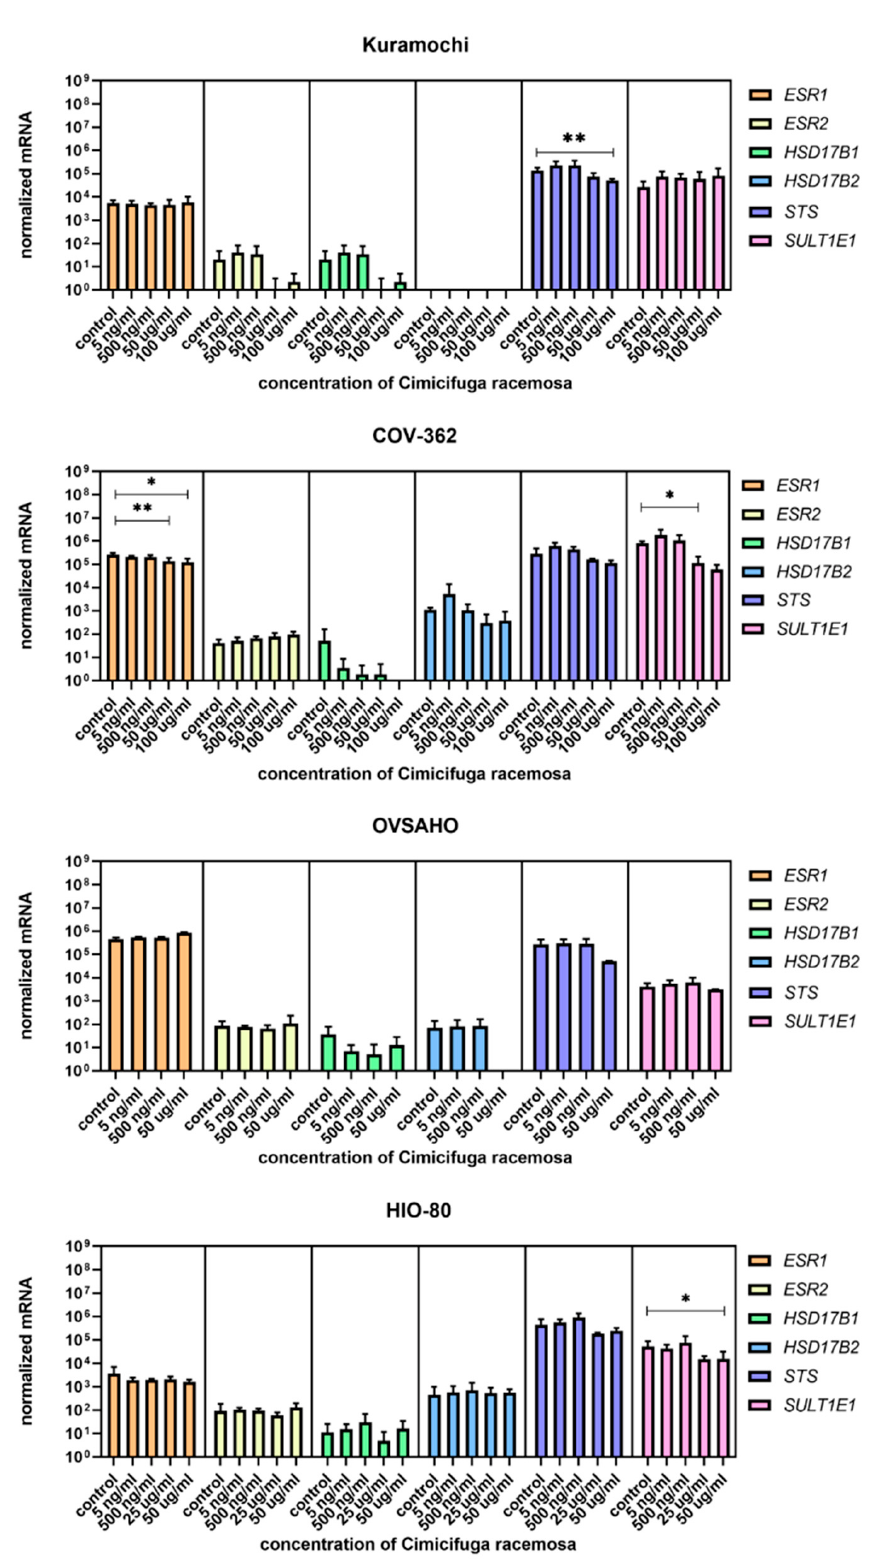
Figure 11. Normalized expression of genes encoding estrogen receptors and genes involved in estradiol biosynthesis and metabolism and genes encoding estrogen receptors in ovarian cancer cell lines Kuramochi, COV-362, and OVSAHO and control cell line HI0-80. At least three independent experiments were performed. Data are shown as mean ± SD. * p -value ≤ 0.05. ** p -value ≤